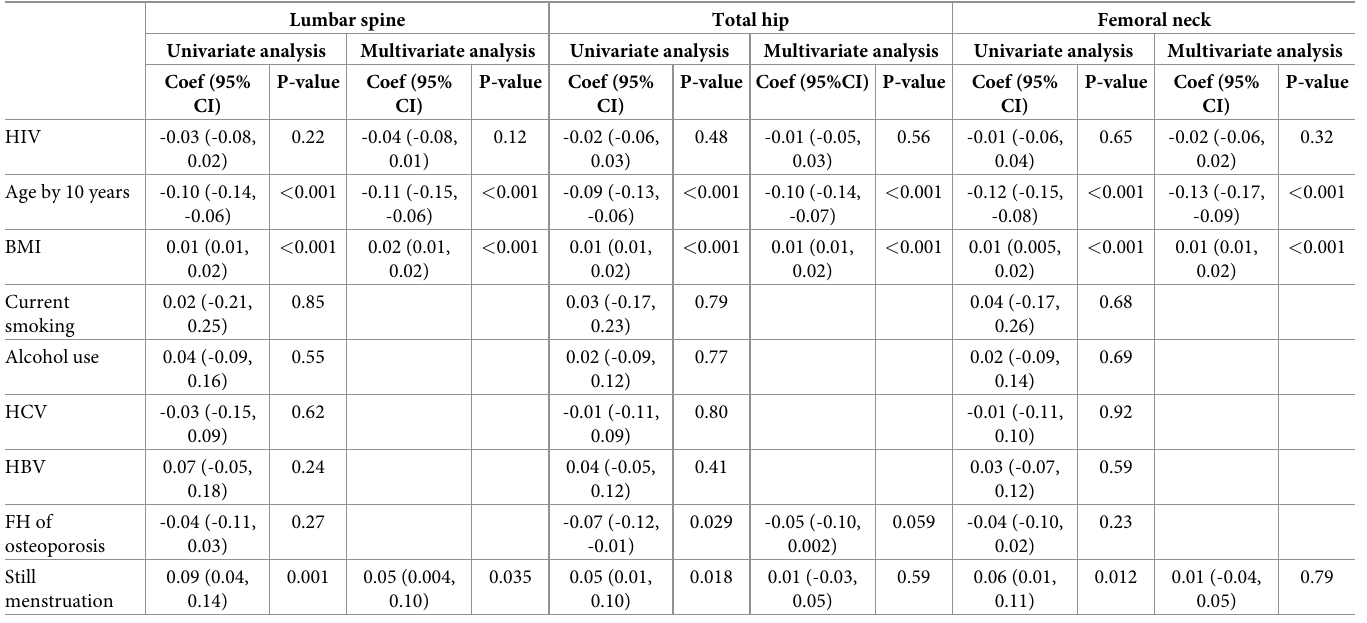
Table 4. Univariate and multivariate analysis of factors associated with BMD at the lumbar spine, total hip, and femoral neck in